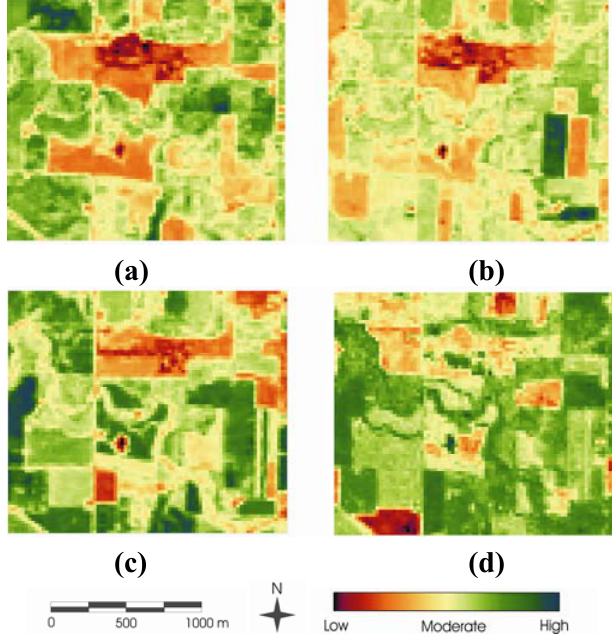
Figure 4. Greenness index characterization time sequence continued: (a) 6 August 2001 (b) 13 September 2003, (c) 10 September 2005, (d) 4 August 2006.